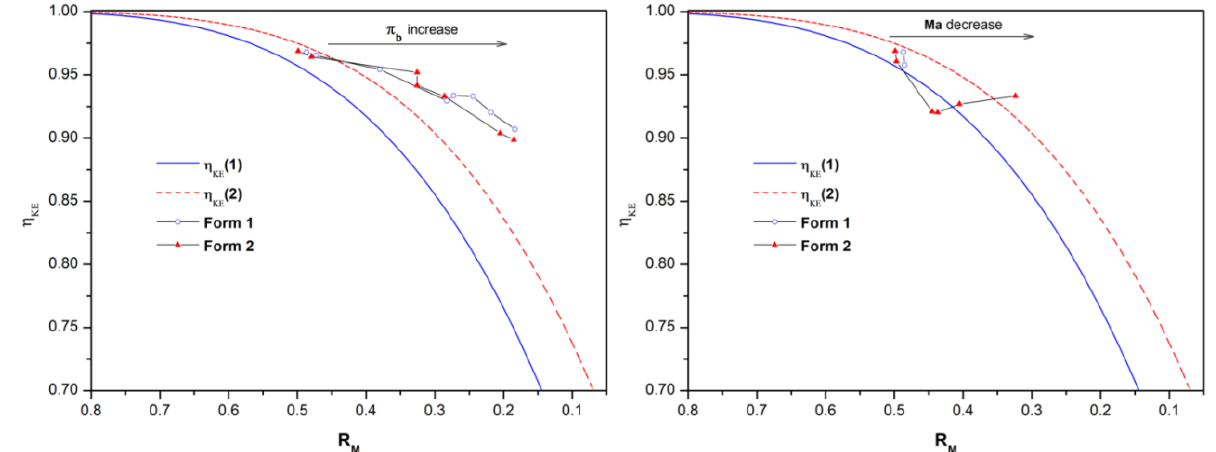
Figure 12. Compression efficiency under different backpressures and inflow conditions.